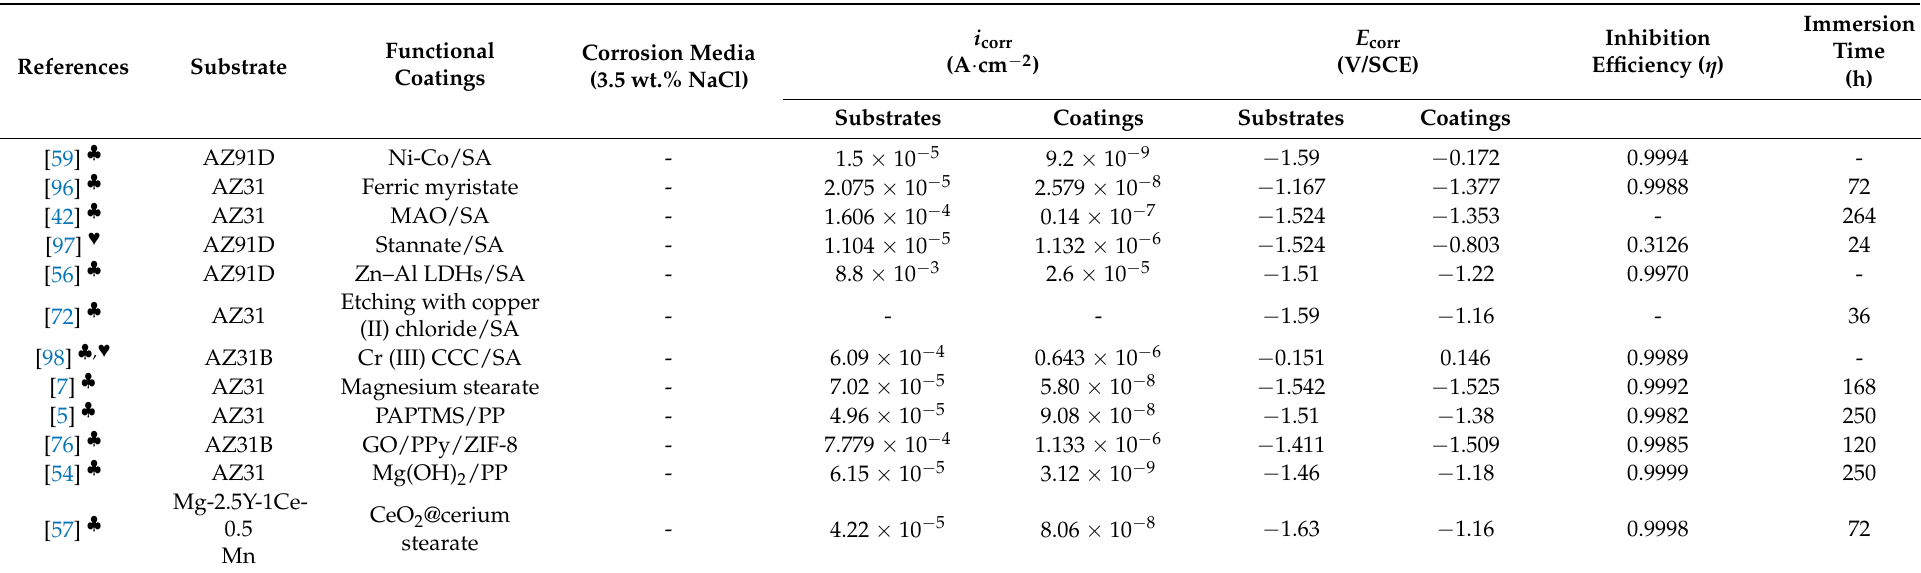
Table 2. Corrosion studies of functional coatings on Mg alloys; ♣ Superhydrophobic coating, (cid:170) self-healing coating, and ♣ (cid:170) Superhydrophobic and self-healing